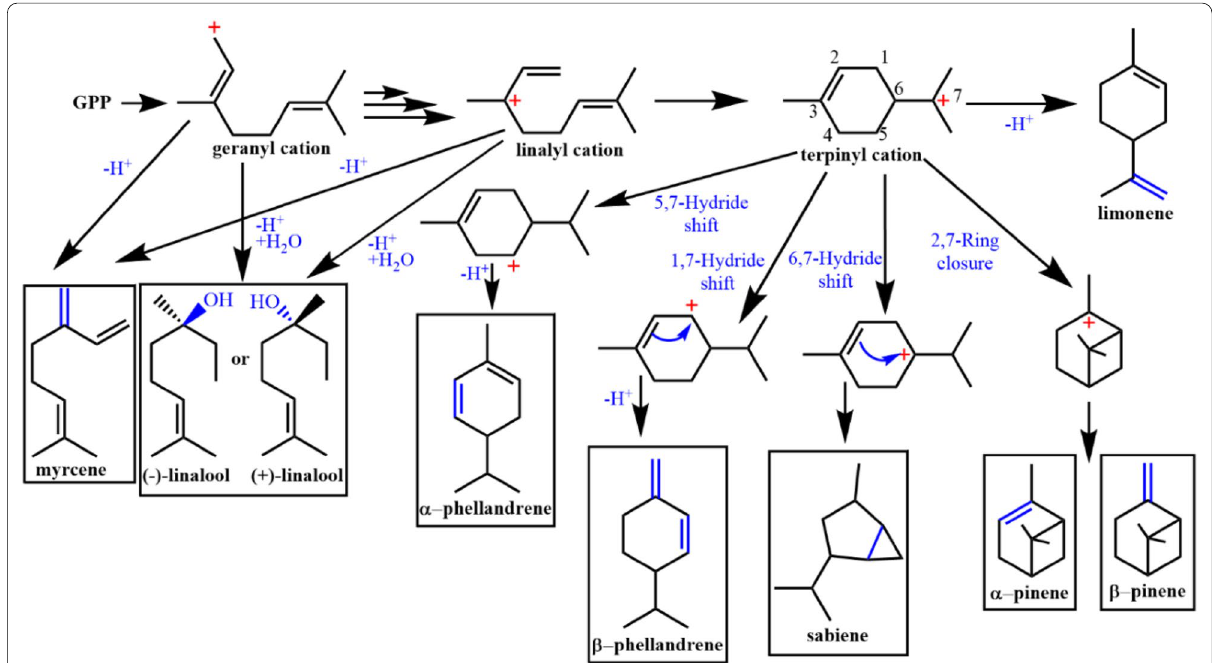
Fig. 7 Proposed monoterpenes that can be achieved by limonene synthase variants. Linalyl cation and terpinyl cation are the common intermediate of monoterpene cyclases, which can produce many monoterpenes